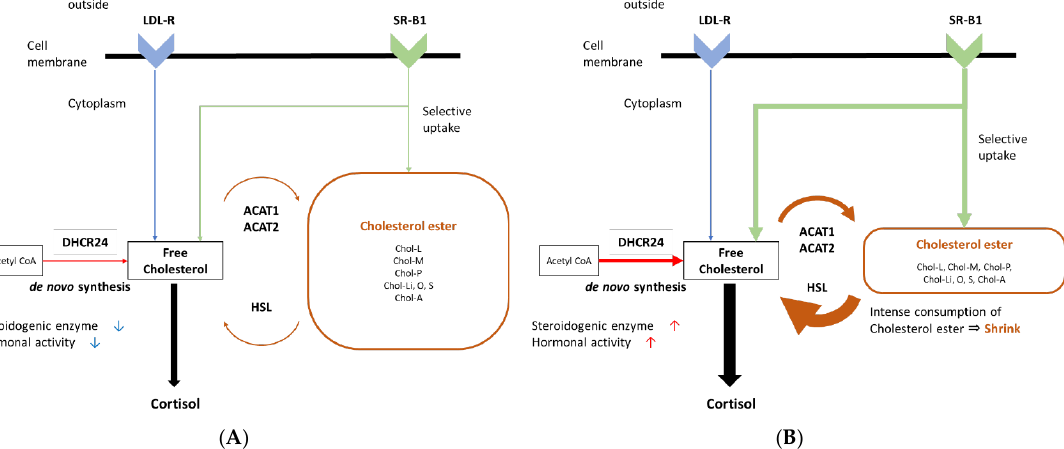
Figure 2. Difference in cholesterol uptake and synthesis depending on morphological features. Differences in cholesterol uptake and metabolism depending on the status of each cell in CPA are illustrated. ( A ): Cholesterol uptake and biosynthesis in relatively cholesterol enriched cells including clear tumor cells. Both cholesterol uptake and synthesis were low, and hormonal activity was also relatively low. ( B ): Cholesterol uptake and synthesis in cholesterol starved cells including compact tumor cells. Both cholesterol uptake and synthesis were increased, and hormonal activity was high. Increased cholesterol synthesis through the cholesterol ester metabolism could contribute to its characteristic shrinked morphology.